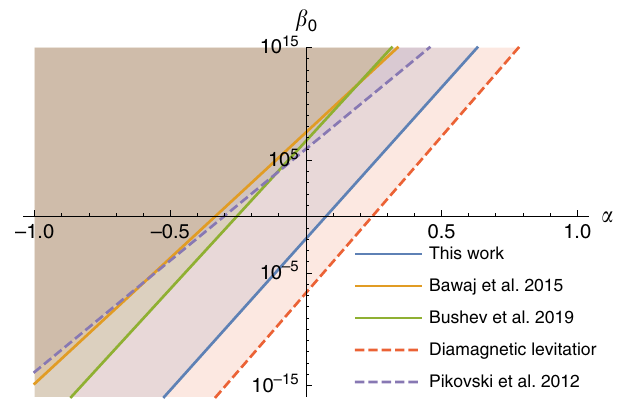
Fig. 1 Excluded regions of parameter space from different experiments. This fi gure depicts the values of the two quantum gravity parameters β 0 , α that are excluded based on experimental observations. Solid lines represent bounds obtained from experimental data and dashed lines represent expected bounds from proposed experiments. The shaded areas represent the region excluded by these experiments. The present work based on 26 provides the largest excluded region of parameters which, in particular, excludes the key point β 0 = 1, α = 0, thereby showing that suppression of quantum gravity deformations should be accounted for if β 0 ~ 1 as expected from quantum gravity models. The proposal to use massive levitated diamagnetic objects described in the text promises signi fi cant improvement in bounds if the optimistic parameters required for such an experiment can be